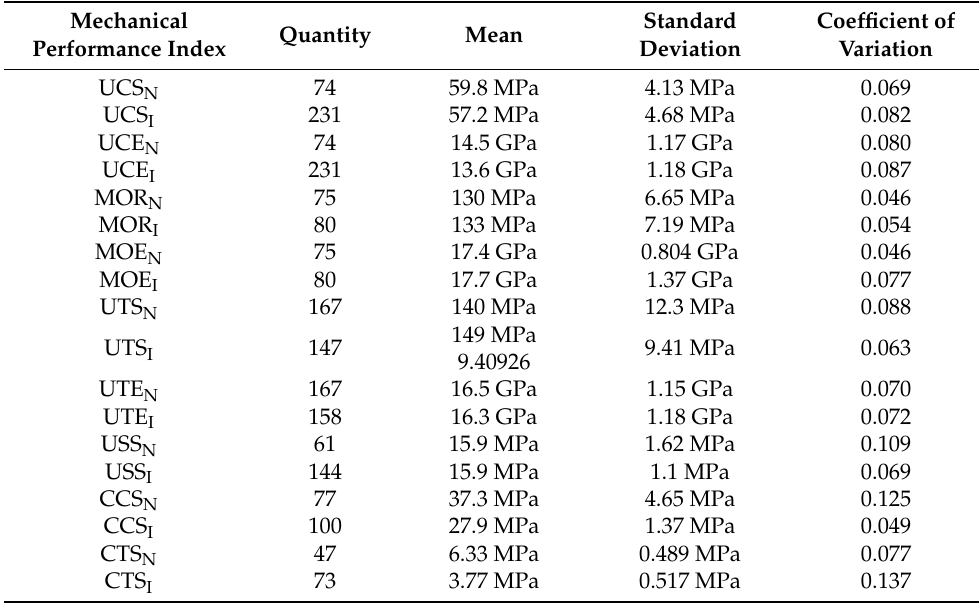
Figure 7. Box normal diagram of mechanical property statistics: ( a ) UCS; ( b ) UCE; ( c ) MOR; ( d ) MOE; ( e ) UTS; ( f ) UTE; ( g ) USS; ( h ) CCS; ( i ) CTS. Table 2. Statistical results of the characteristic values of the mechanical properties.